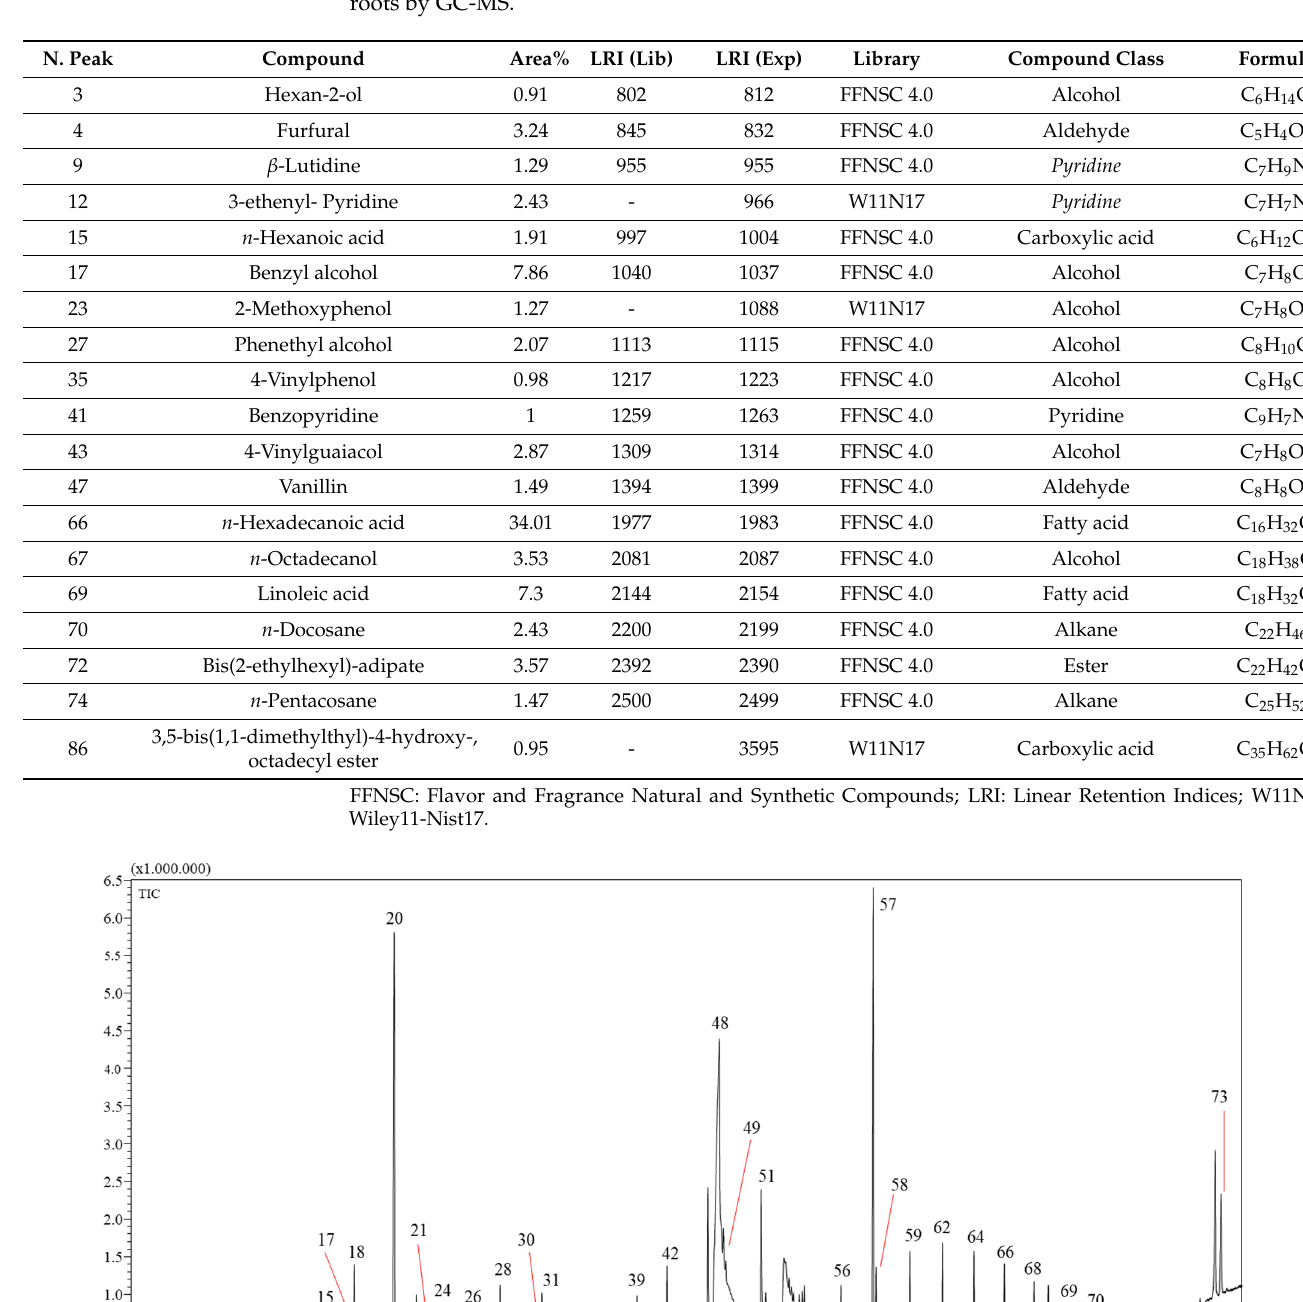
Table 2. List of major volatile compounds detected in the chloroform fraction (VF2) of C. althaeoides L. roots by GC-MS.